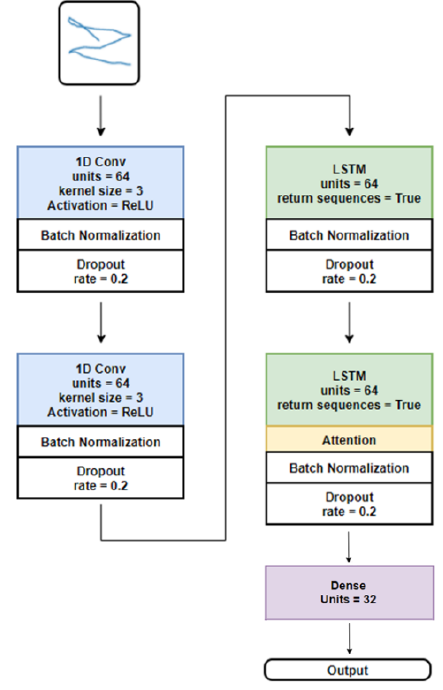
Figure 7. Network structure of base model. It consists of two convolutional blocks, two LSTM blocks, and a fully connected network. A convolutional block consists of a convolutional layer, a batch normalization layer, and a dropout layer, and an LSTM layer consists of a batch normalization layer and a dropout layer. An attention layer is inserted into the second LSTM layer to improve the network performance. The network parameters are as described in the figures.